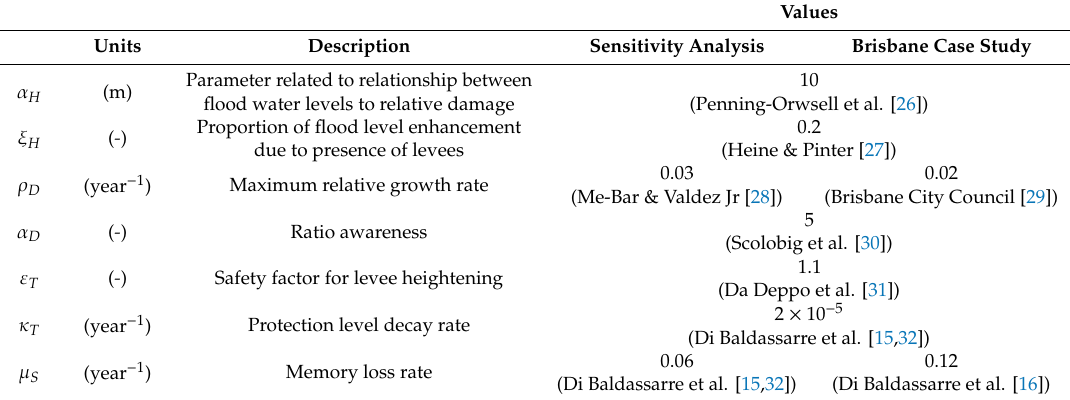
Table 4. Time-invariant parameters of the flooding module, values, and references used in the sensitivity analysis and the Brisbane case